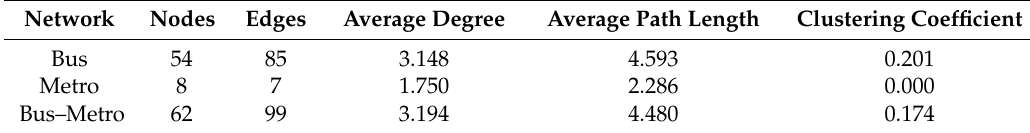
Figure 6. Bus–Metro CBN of Xi’an City after a rainstorm on 24 July 2016. ( a ) Bus stop after a rainstorm. ( b ) XIAOZHAI metro station after a rainstorm. Table 3. Feature parameters of Xi’an Bus–Metro CBN and corresponding E-R random network.